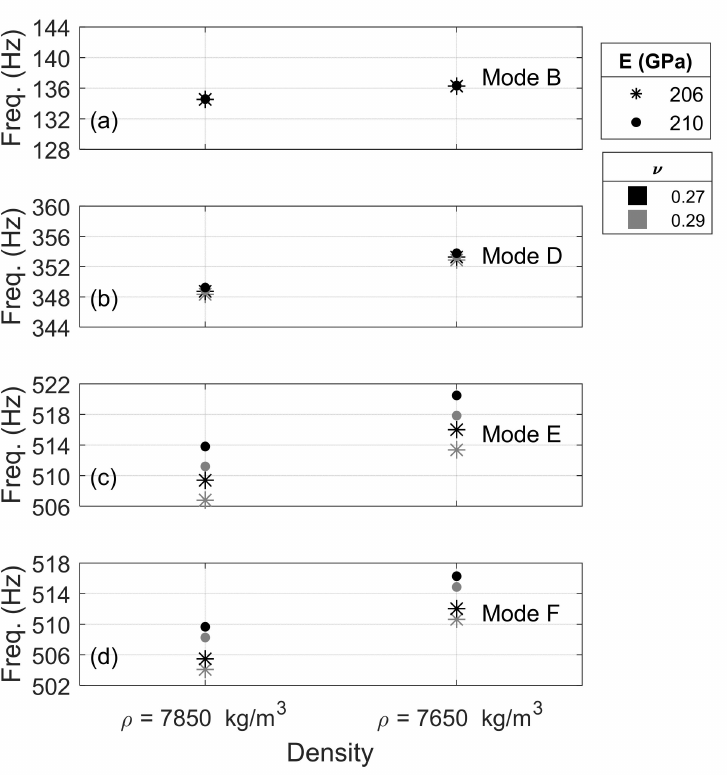
Figure 7. Sensitivity analysis. Effect of the rail material properties on the frequency of vibration of modes B, D, E, and F shown in subplots ( a ), ( b ), ( c ), and ( d )